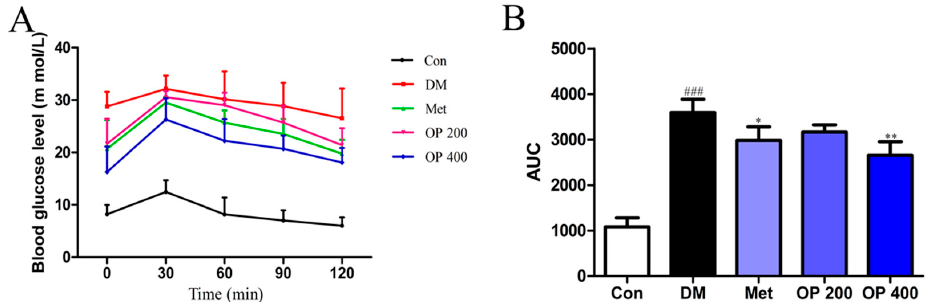
Figure 2. Effects of OP on glucose tolerance test ( A ) and area under curve (AUC) ( B ) in the oral glucose tolerance test (OGTT) mice. Each value is mean ± SD of eight mice in experimental groups. ### p < 0.001 vs control, * p < 0.05, ** p < 0.01 vs model.